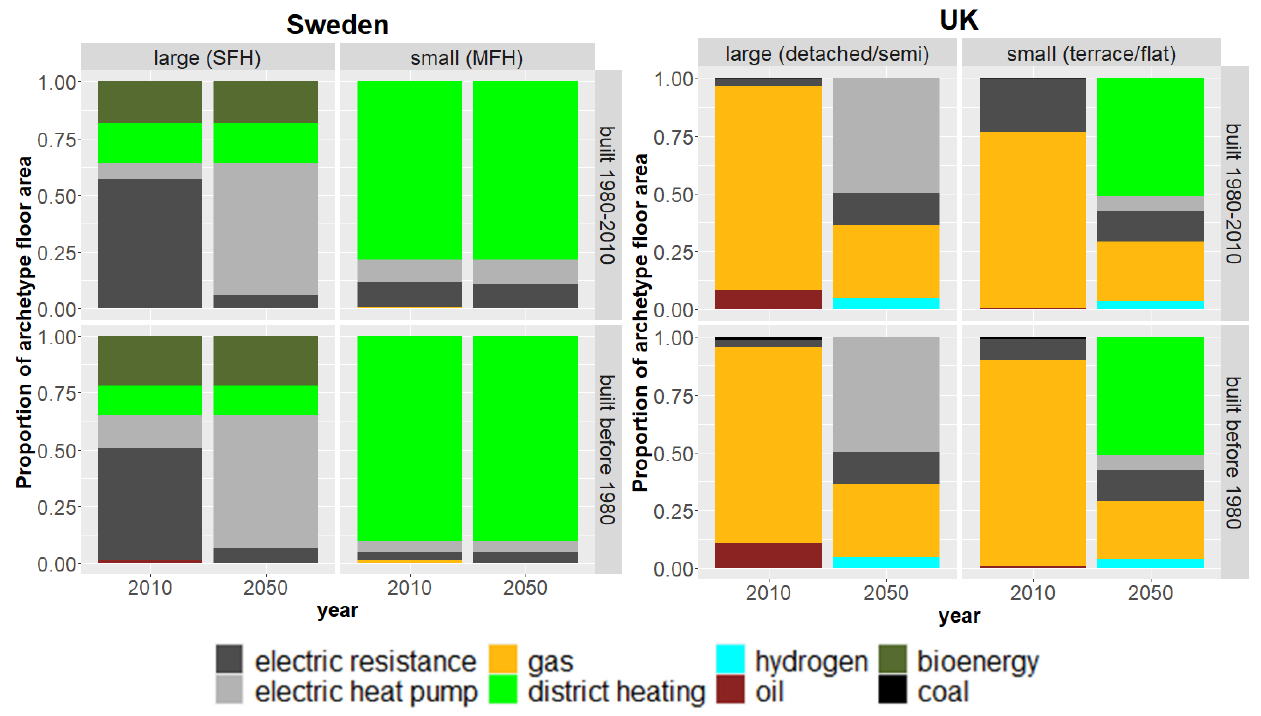
Figure 8. Share of floor area with each form of heating for UK and Swedish dwelling archetypes in 2010 and 2050 (authors’ analysis).